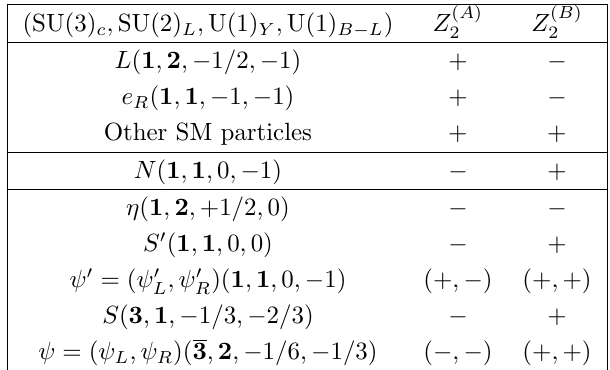
2 is broken softly via the (cid:22) -term, see 2